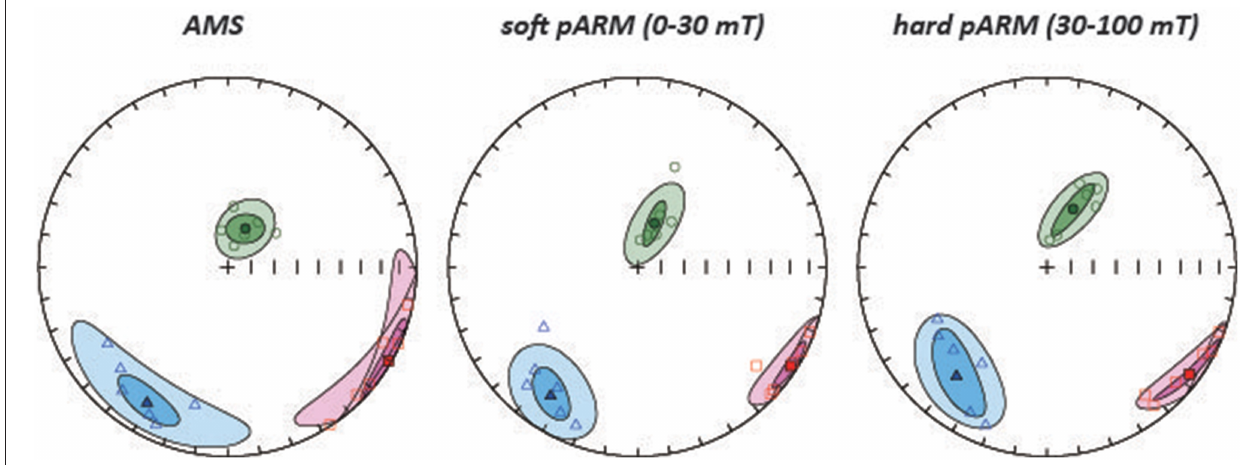
FIGURE 8 | Stereographic projections of anisotropy of magnetic susceptibility (AMS), anisotropy of partial anhysteretic remanent magnetization (partial AARM). Soft partial AARM (0–30 mT) and hard partial AARM (30–100 mT) were produced in a bias DC field of 100 µ T. Samples were AF demagnetized to 100 mT before each partial ARM acquisition experiment. For each stereographic projection, eigenvectors are displayed on an equal area plot using the lower hemisphere projection with the convention that maximum ( k 1 ), intermediate ( k 2 ), and minimum ( k 3 ) susceptibility are represented as red squares, blue triangles, and green circles. Confidence ellipses were calculated on the basis of the Jelinek method (inner ellipses with darker colors) and the site parametric bootstrap statistics (outer ellipses with brighter